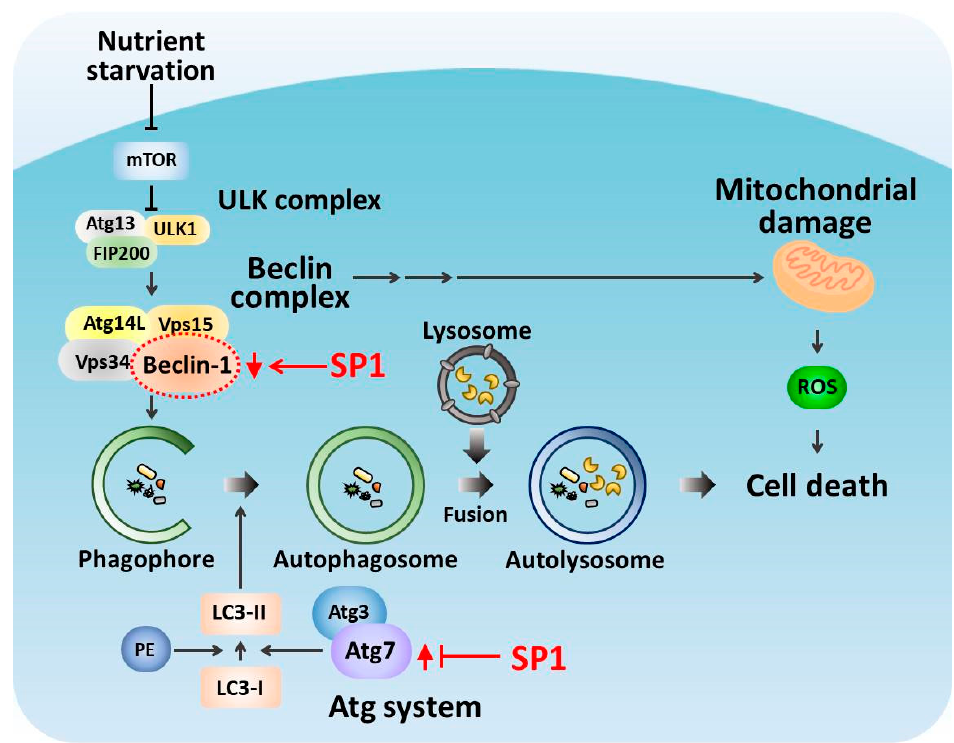
Figure 7. The predicted molecular pathway of SP1 involved in the inhibition of autophagy-mediated apoptosis induced by starvation. SP1 suppresses the EBSS-induced increase in ATG7 level, and regulates the basal Beclin-1 level.